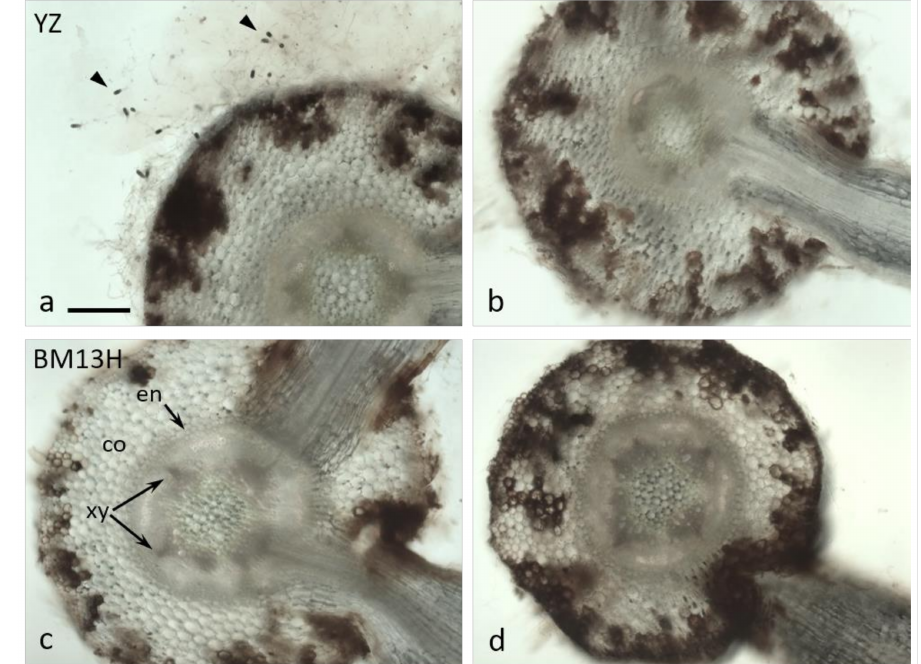
Figure 3. Cross-sections of roots from susceptible (YZ— a , b ) and resistant (BM13H— c , d ) G. arboreum seedlings 7 days after inoculation with BRR spores in sterile culture. The epidermis and cortex became colonized to varying degrees in both accessions, with dark fungal hyphae and cortical blackening generally more extensive in YZ roots. Abundant spores (arrowheads in a ) are evident emerging from fungal mycelium on YZ roots. co = cortex, en = endodermis, xy = xylem poles (2 of 5 indicated in c ) Bar in a for a – d = 0.2 mm.